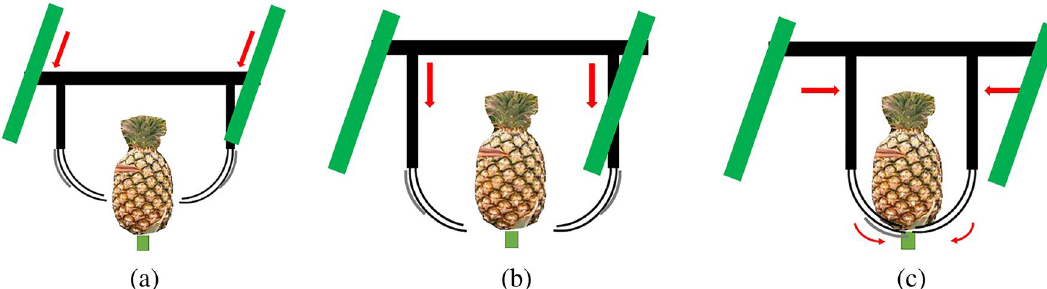
Figure 3. Preliminary plan for simple harvesting mechanism: ( a ) lateral alignment of harvesting mechanism; ( b )lowering of clamping device; ( c ) closure of clamping device around stem beneath fruit.